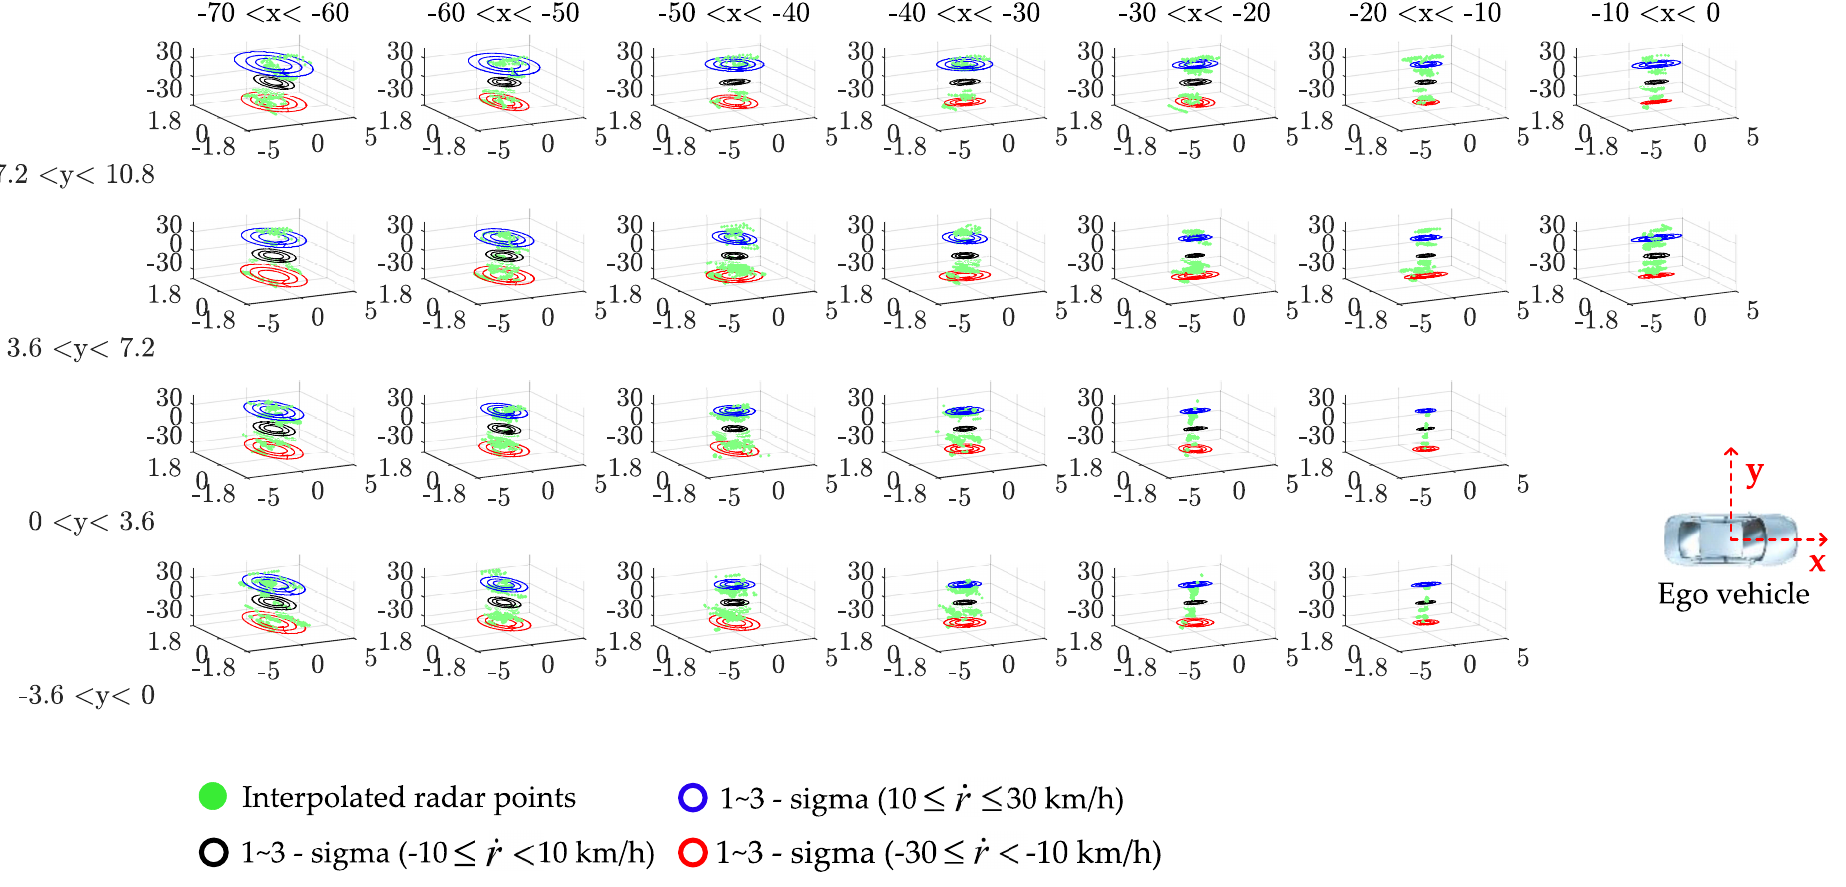
Figure 6. Data-driven radar accuracy analysis in the divided occupancy zone: each zone shows the probability density function contour (1 σ , 2 σ , and 3 σ ) of the normal distribution for radar’s position error based on differential global positioning system (DGPS). Contour lines are shown in blue, black, and red for each speed data